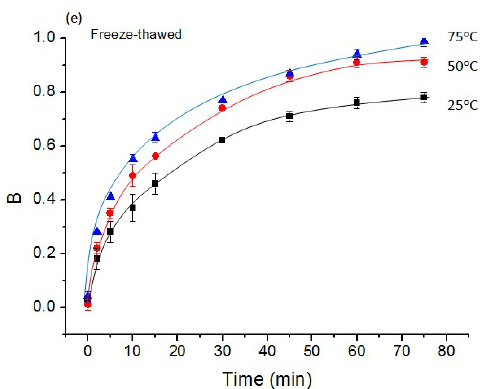
Figure 7. Normalized Brix function, B , during aqueous extraction from untreated ( a ), PEF treated at 400 V/cm ( b ), 600 V/cm ( c ), 800 V/cm ( d ), and freeze-thawed ( e ) Jerusalem artichokes.